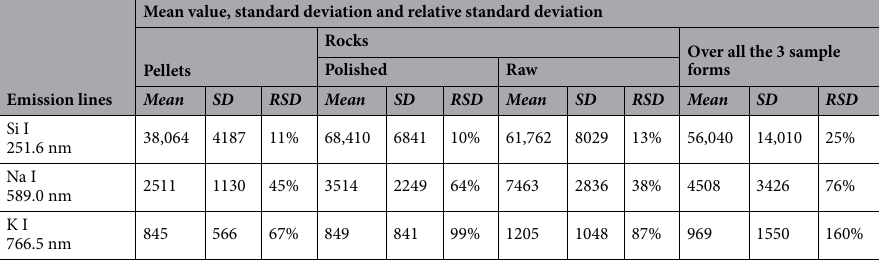
Table 1. Mean value, standard derivation ( SD ) and relative standard deviation ( RSD ) of the intensities of the Si I 251.6 nm, Na I 589.0 nm, and K I 766.5 nm lines, recorded from sample S1 in the 3 the forms of pressed pellet, polished and raw rocks, as well as calculated over all the replicate spectra of the 3 sample